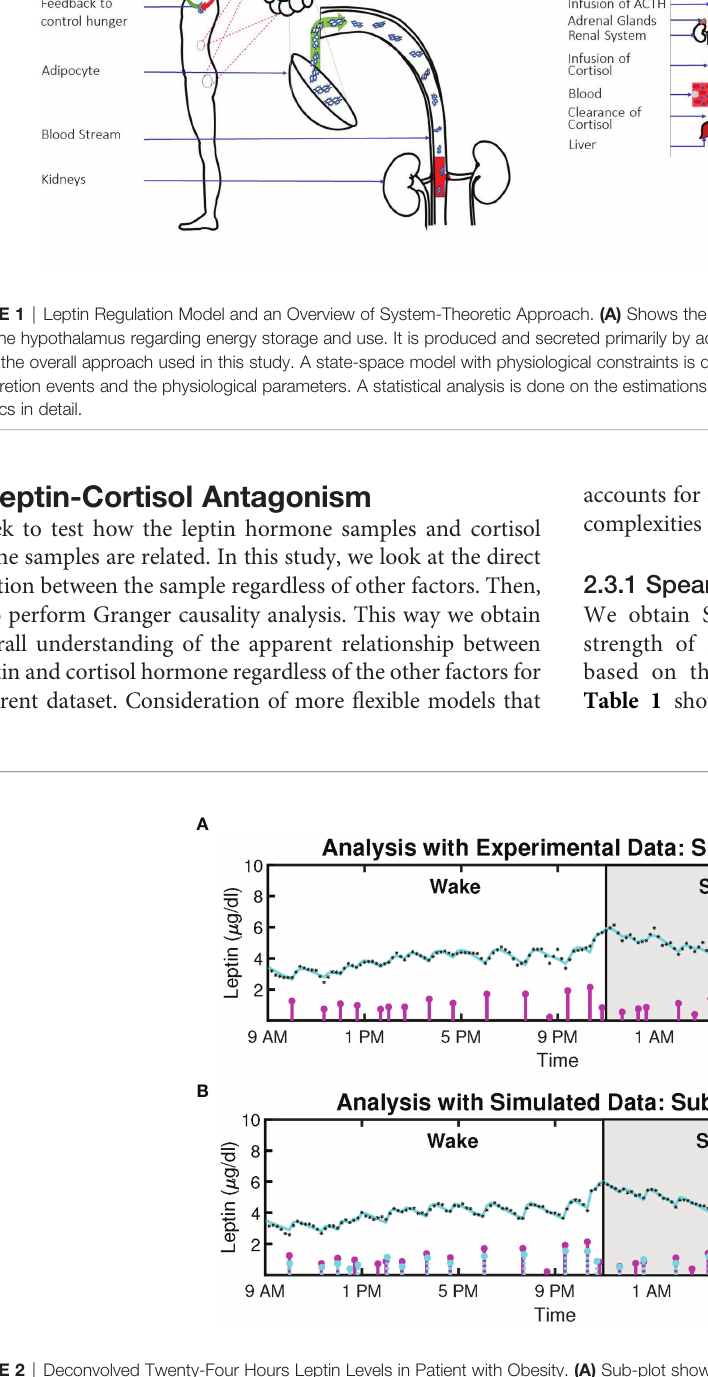
FIGURE 2 | Deconvolved Twenty-Four Hours Leptin Levels in Patient with Obesity. (A) Sub-plot shows the measured 24-hour leptin time series (black diamonds), the reconstructed leptin levels (cyan curve), the estimated pulse timings, and amplitudes (magenta vertical lines) for experimental data. (B) Sub-plot shows the simulated 24-hour leptin time series (black diamonds), the reconstructed leptin levels (cyan curve), the simulated pulse timings and amplitudes (cyan vertical lines), the recovered pulse timings, and amplitudes (magenta vertical lines) for simulated